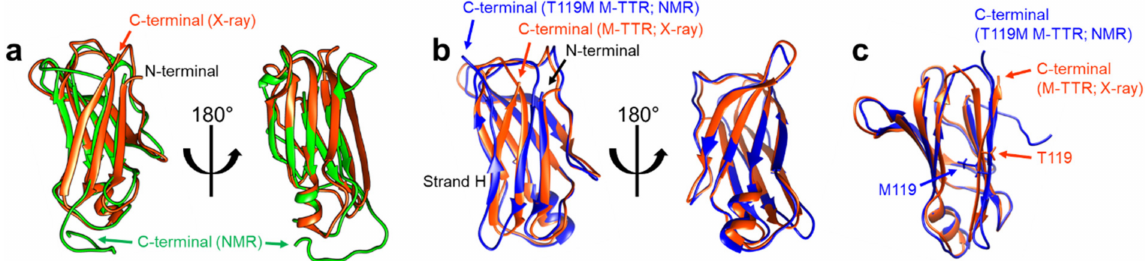
Figure 3. NMR solution structural models of M-TTR (PDB 2NBO [35]) and T119M M-TTR (PDB 2NBP [34]). ( a ) The NMR structural model of M-TTR (the lowest energy conformer; green) is shown with the X-ray crystallographic model of M-TTR in the tetrameric state (PDB 1GKO [36]; orange). Note that the last β -strand H in the X-ray model is disoriented in the NMR model [35]. ( b ) The NMR structural model of T119M M-TTR (the lowest energy conformer; blue) is shown with the X-ray model of M-TTR (orange). The last β -strand H, shown in the X-ray model, which is missing in the NMR model of M-TTR (a), is visible here, with a non-native β -strand structure [34]. ( c ) Comparison between the X-ray model of tetrameric M-TTR (orange) and the NMR model of monomeric T119M M-TTR (blue). Note that the sidechain of T119 in M-TTR is oriented outward, whereas the sidechain of M119 in T119M M-TTR is directed inward